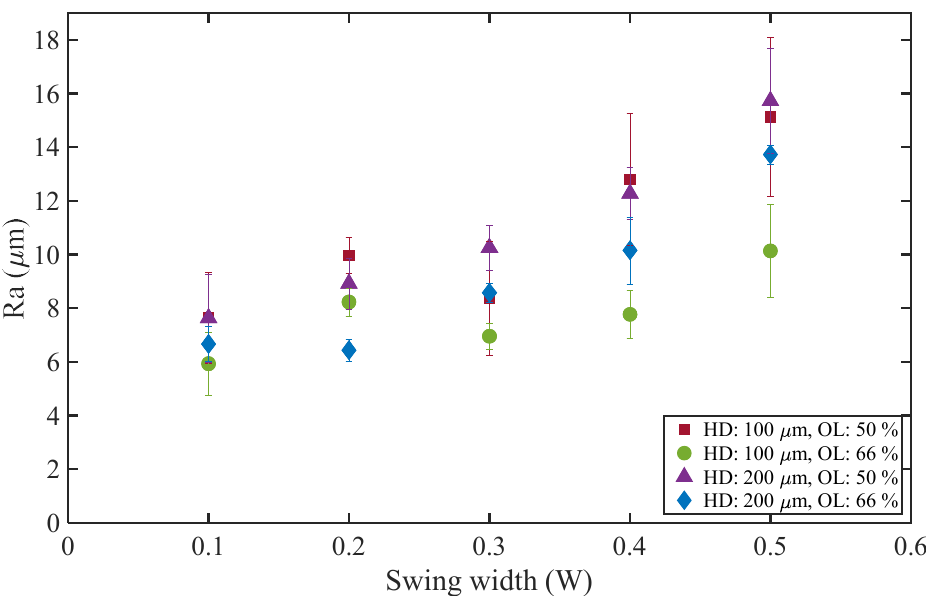
Figure 6. Surface roughness of WBS at different swing widths (scanning speed 50 mm/s).